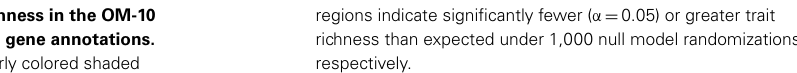
regions indicate significantly fewer ( α = 0.05) or greater trait richness than expected under 1,000 null model randomizations,